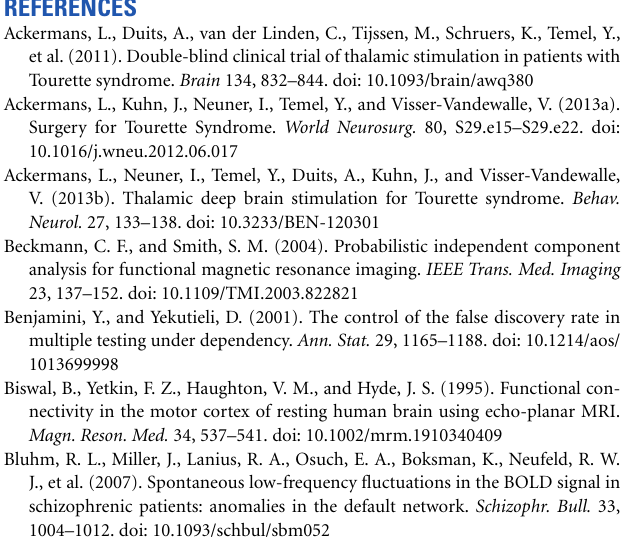
Supplementary Figure 2 | BOLD signal time-course in subject 6 for. (A) t-2, (B) t-1, and (C) tic onset. The time-course was extracted at the voxel